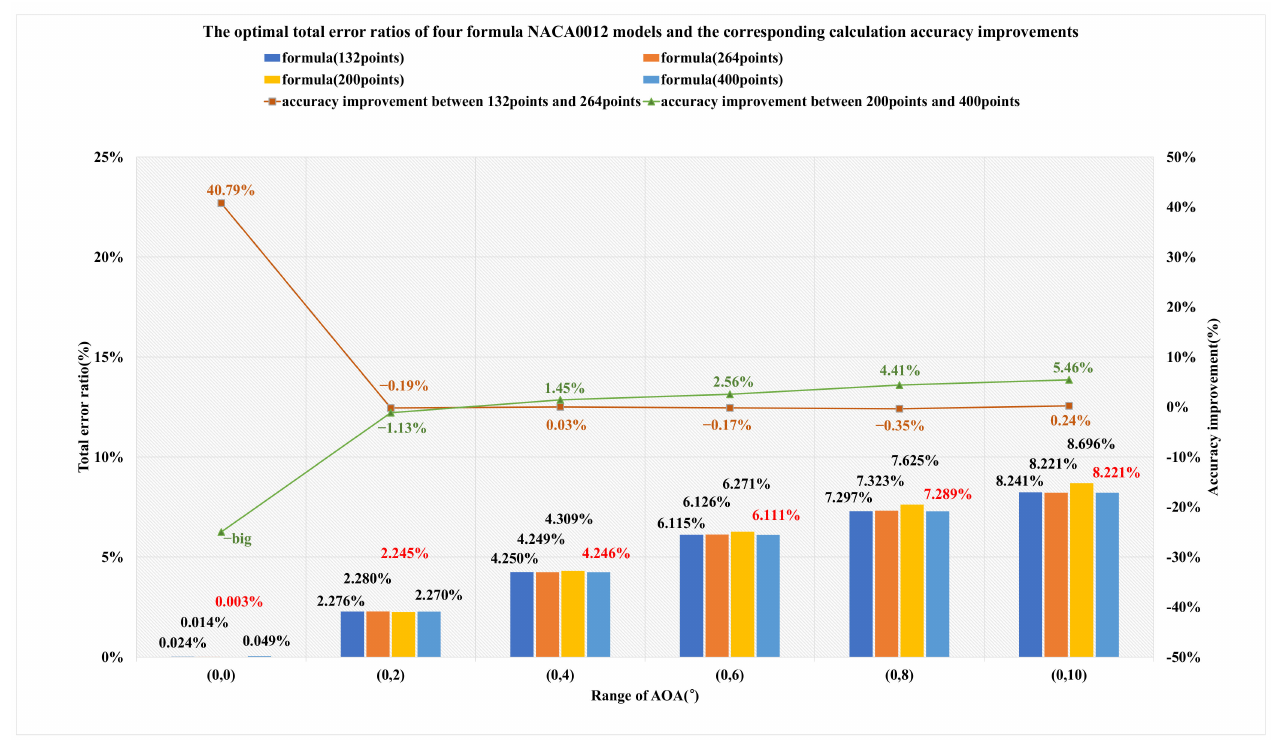
Figure 18. The optimal total error ratios of four formula models and the corresponding calculation accuracy